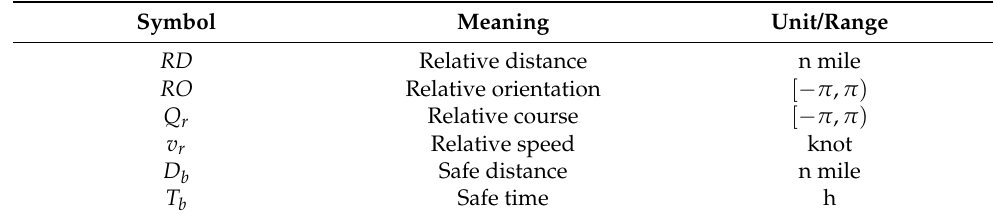
Table 1. Definition of